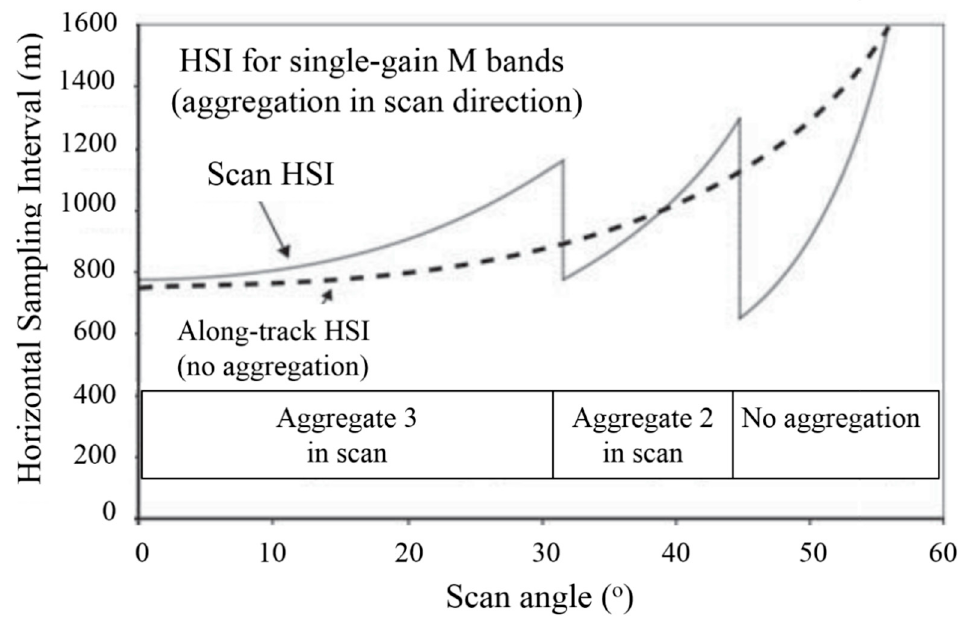
Figure 3. The effects of pixel aggregation on the growth of VIIRS pixels. HSI: Horizontal Sampling Interval. After [57].